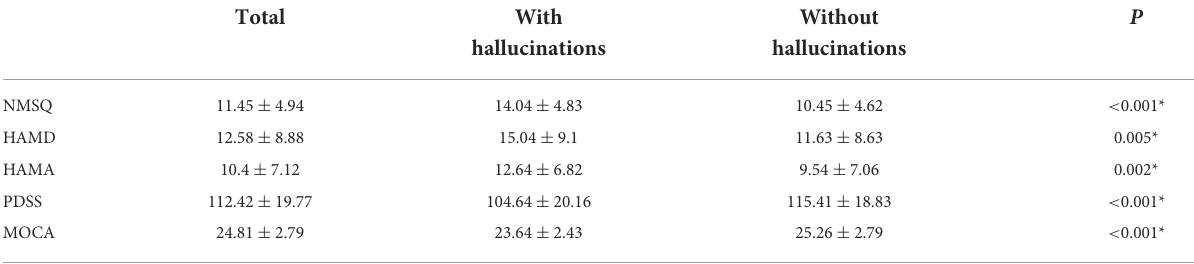
TABLE 3 Non-motor characteristics of Parkinson’s disease patients based on the presence/absence of hallucinations. Total With hallucinations